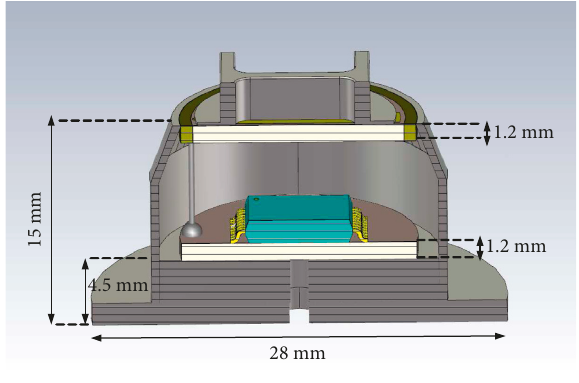
Figure 9: The dimensions of the field